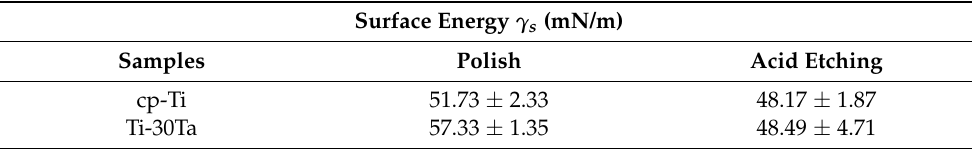
Table 5. Surface energy of the non-coated cp-Ti and Ti-30Ta samples.